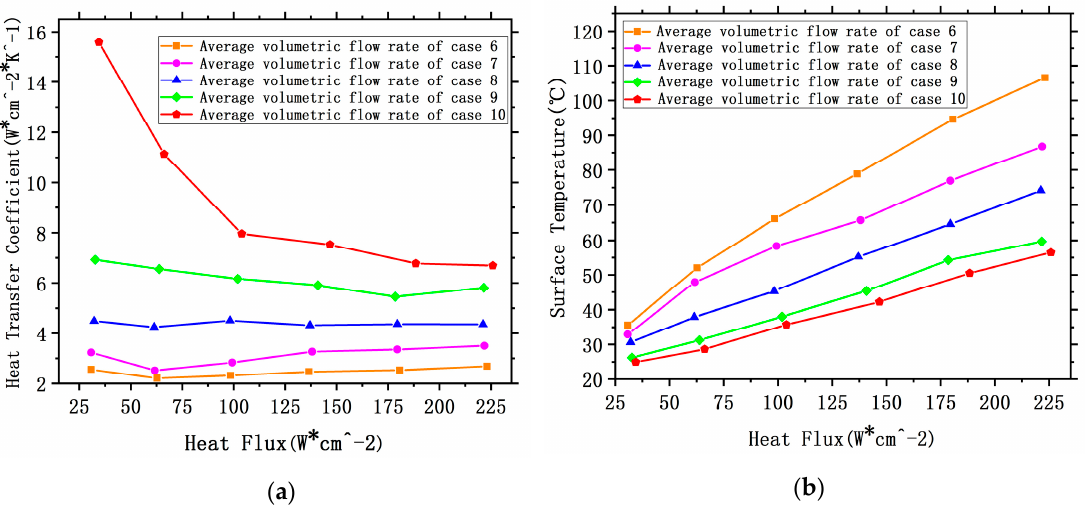
Figure 8. Characteristic heat transfer curves for various spray volumetric flow rates (SVFRs), ( a ) heat transfer coefficient as a function of heat flux and ( b ) surface temperature as a function of heat flux.